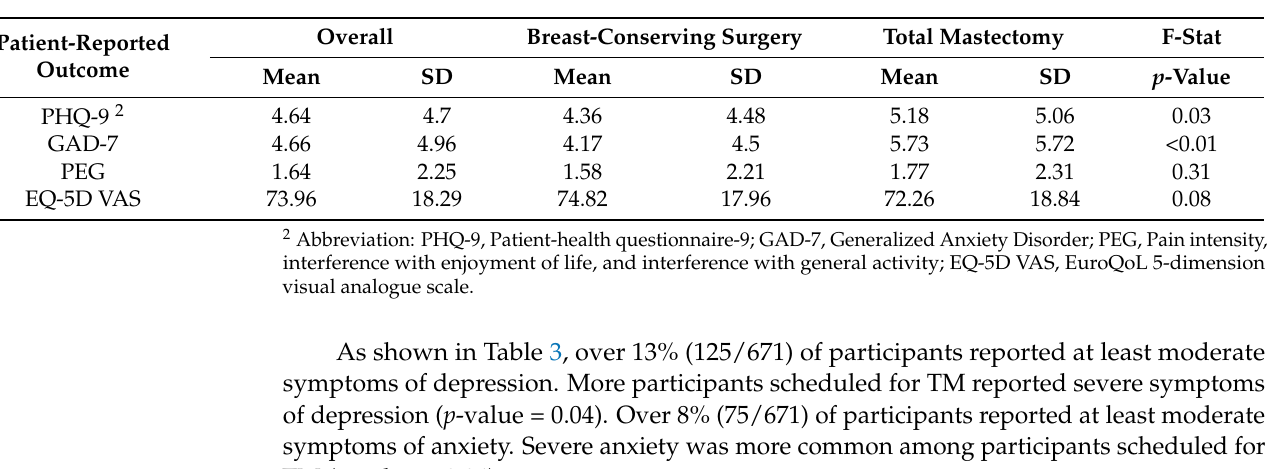
Table 2. Patient-reported outcome statistics presented for the overall sample and stratified by breast- conserving surgery and mastectomy.